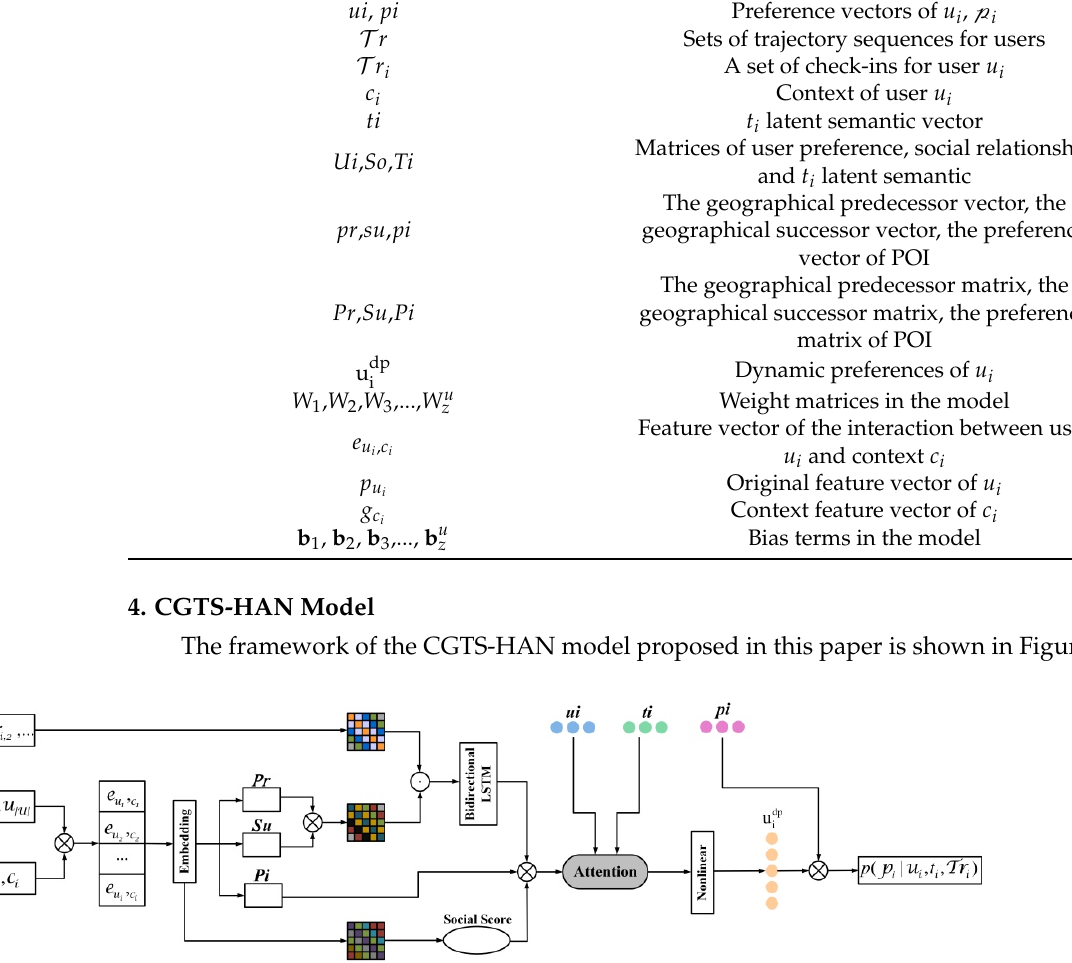
Table 1. Main Notation.